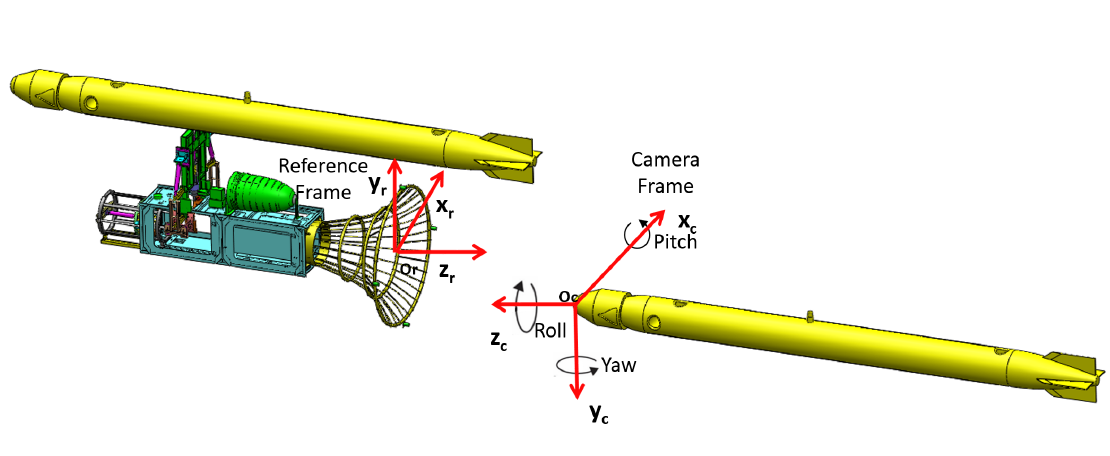
Figure 4. Coordinate frames in